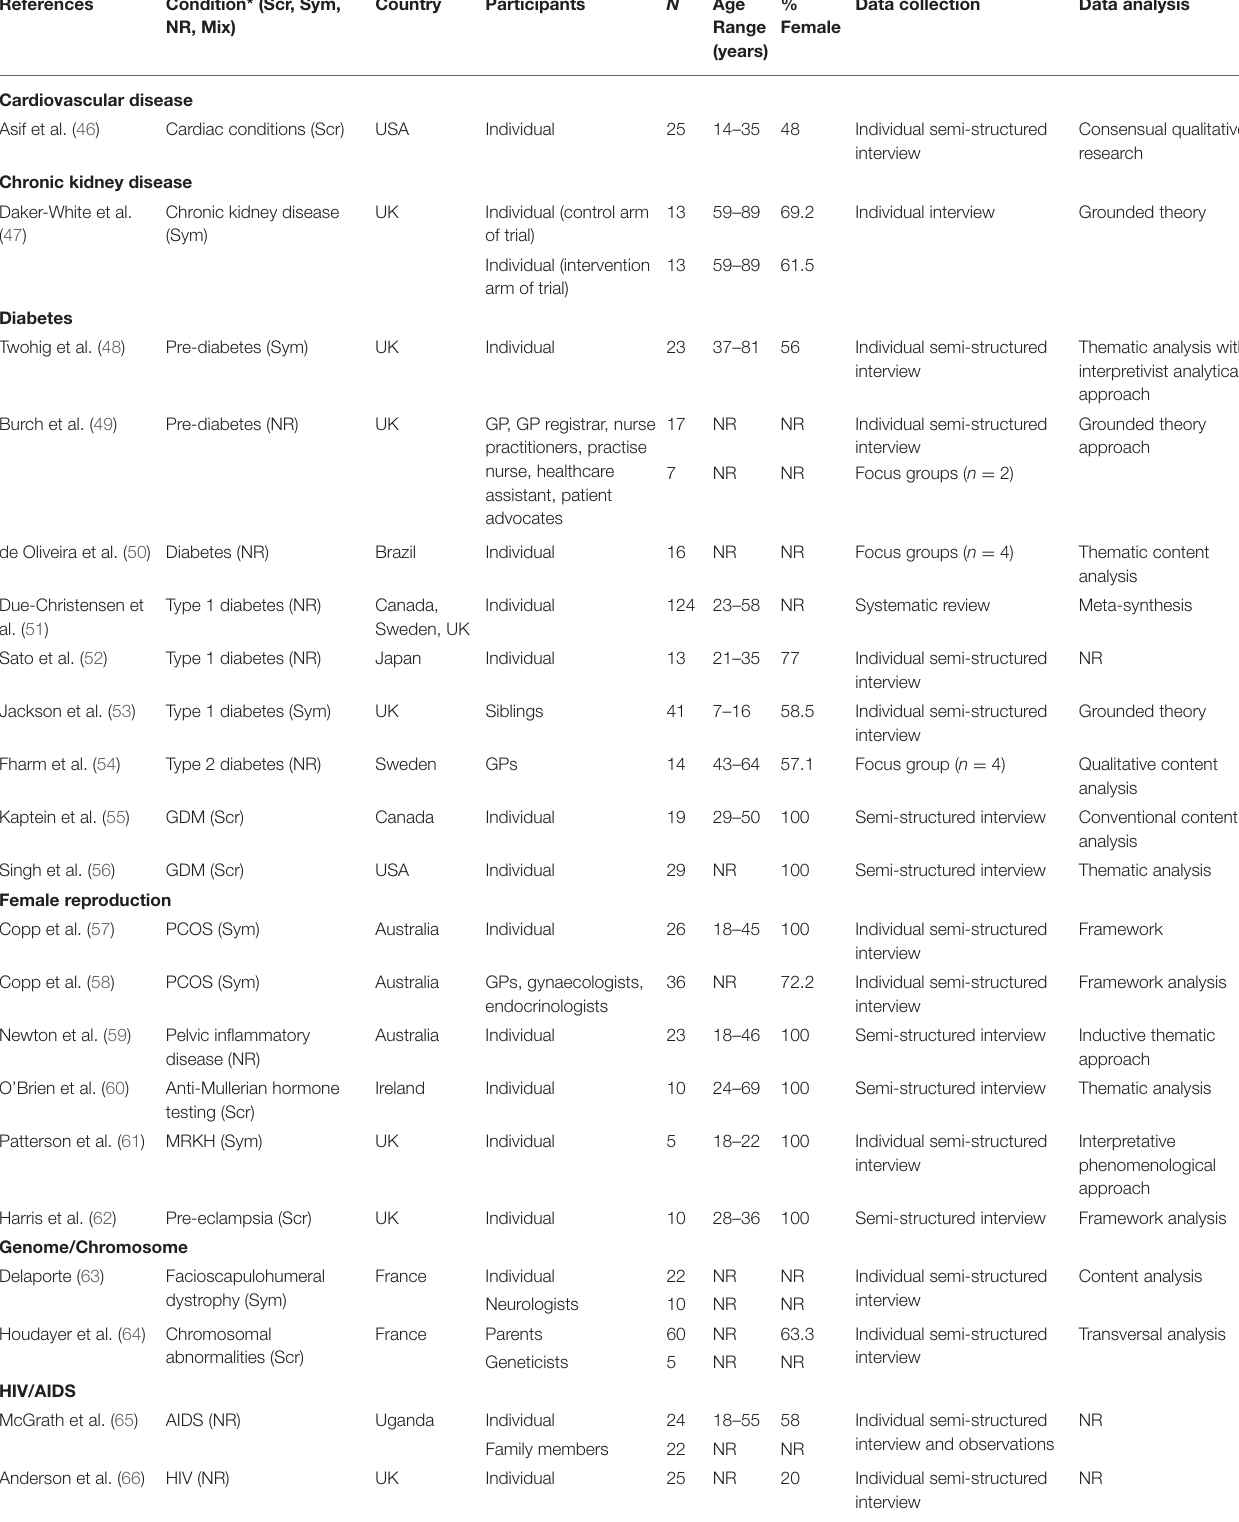
TABLE 1 | Key characteristics of extracted qualitative studies and